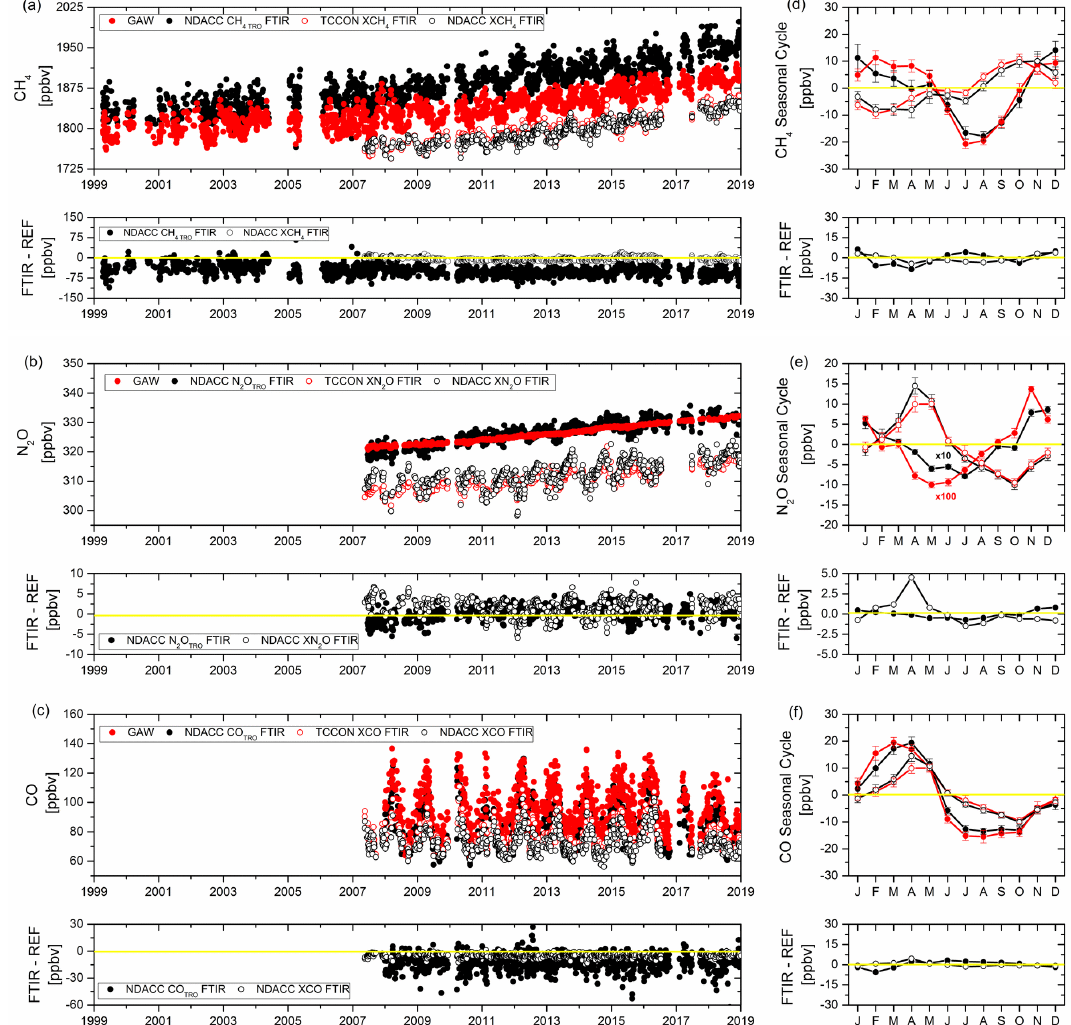
Figure 13. As for Fig. 12, but for tropospheric and column-averaged NDACC products: (a, d) CH 4 , (b, e) N 2 O, and (c, f)